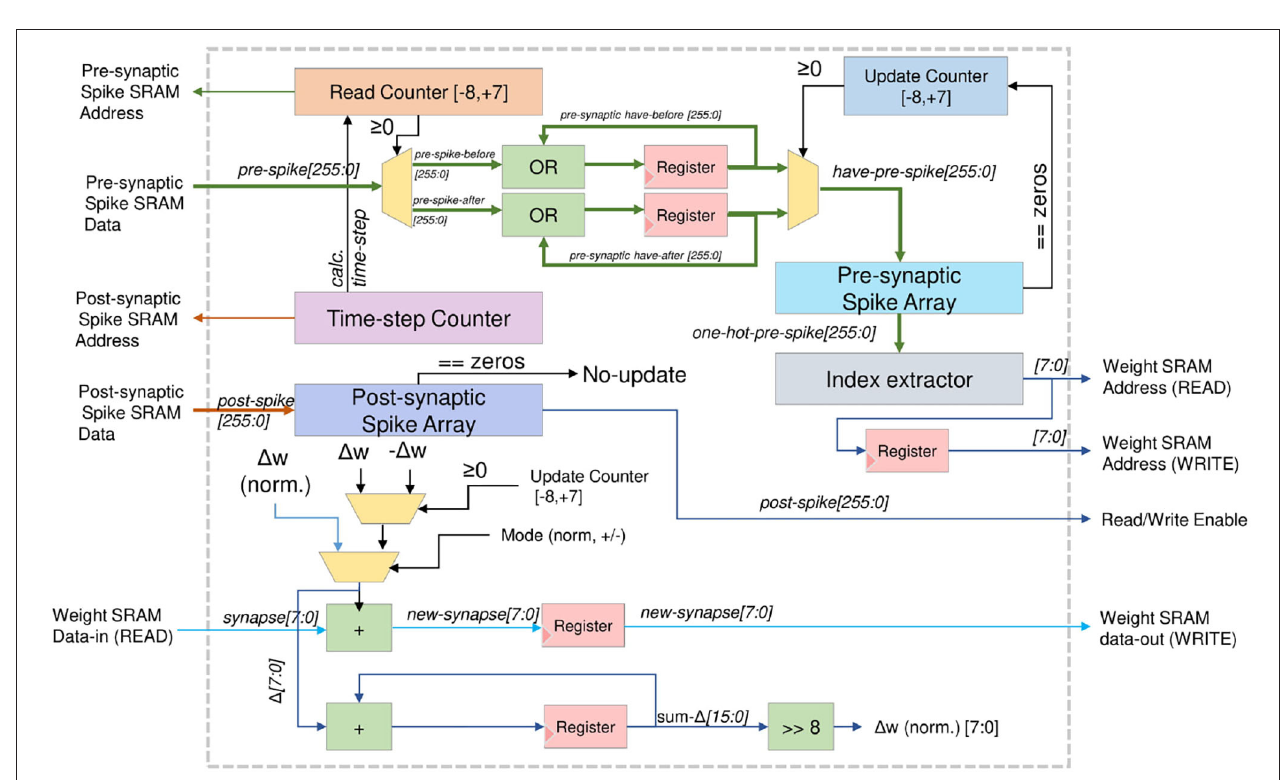
FIGURE 7 | On-chip STDP learning